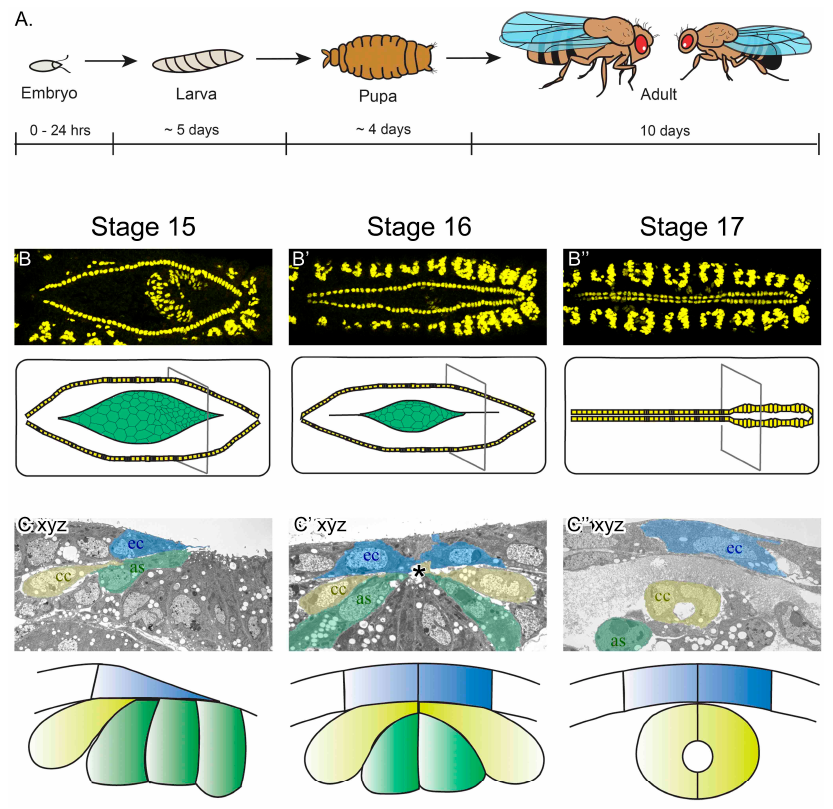
Figure 1. Drosophila melanogaster embryonic heart development. ( A ) Although the lifecycle of flies, from egg-laying to adult is approximately 10 days at 25 ◦ C, embryogenesis completes in just 24 hours. It is during embryogenesis that the heart develops into a linear tubular organ. ( B–B” ) Images of the dorsal surface of fixed embryos imaged with a confocal fluorescent microscope (top panels are labeled for dMEF, present in the nuclei of somatic and heart muscle). By embryonic stage 15, the heart cells (yellow in schematic) are aligned in two lateral rows, flanking the amnioserosa tissue (green in schematic). As embryogenesis continues, the cardioblast cells (CBs) migrate towards the dorsal midline (stage 15–17). By the end of stage 17, the embryonic heart is a mature vessel, capable of pumping hemolymph throughout the body. The slightly wider heart vessel is at the posterior (to the right), while the outflow tract extends anteriorly (to the left). ( C–C” ) In transverse sections of fixed embryos imaged using an electron microscope, migrating cardial cells (yellow) follow the dorsal ectoderm leading edge (blue) and contact the amnioserosa (green) ventrally (stage 15). As CBs approach the midline, they migrate between the ectoderm and amnioserosa to reach their contralateral partner at the midline (asterisk, stage 16). Once at the midline, the CBs adopt a crescent-shape morphology and enclose the lumen (stage 17). At this stage, dorsal closure has completed; the ectoderm covers the dorsal surface of the embryo and the amnioserosa has invaginated and the cells are undergoing apoptosis. Dorsal is at the top of C–C” as, amnioserosa; ec, ectoderm; cc, cardial